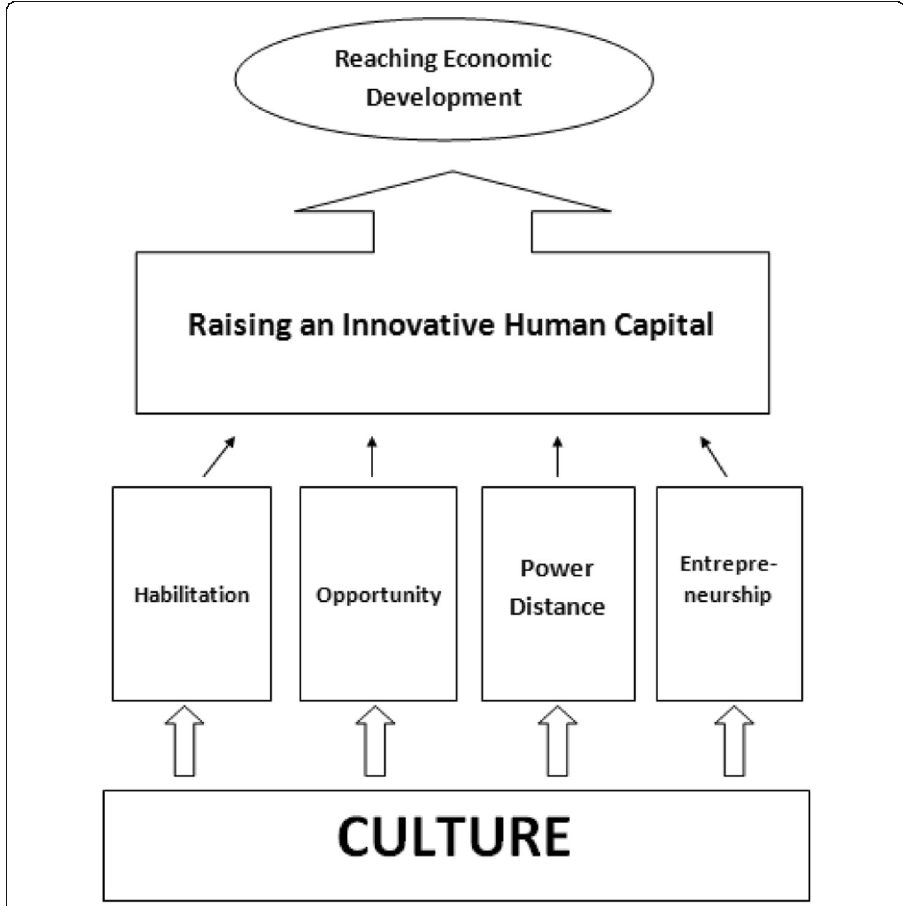
Fig. 2 The impact of culture on the four pillars of raising and innovative human